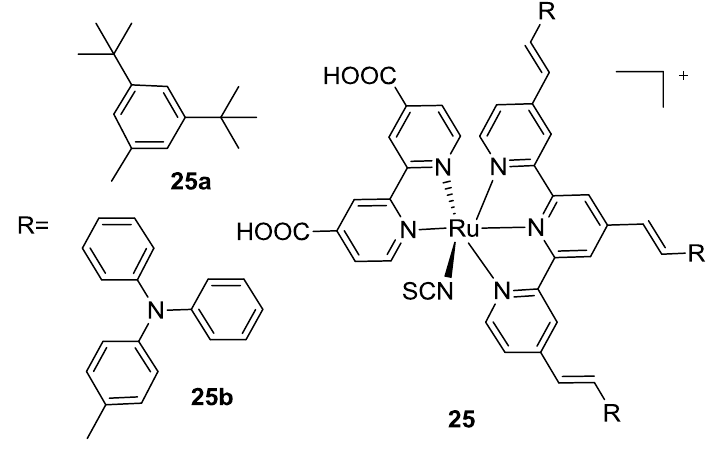
Figure 19. Tpy extended with substituted stiryl moieties by Giribabu [102].